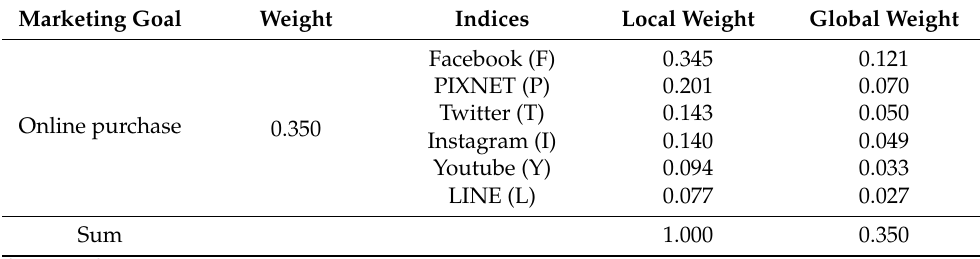
Table 3. AHP online purchase and complimentary social media